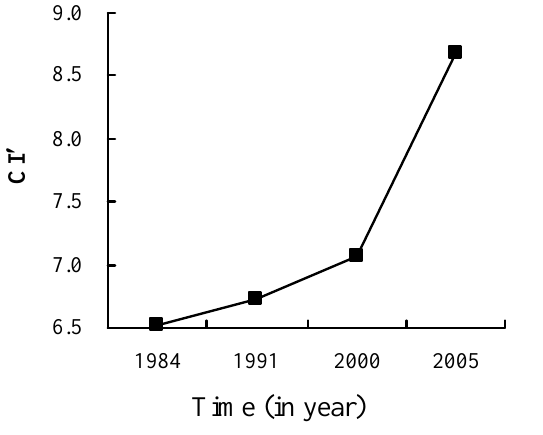
Figure 7. The revised compactness indices. Figure 8. The fractal boundary